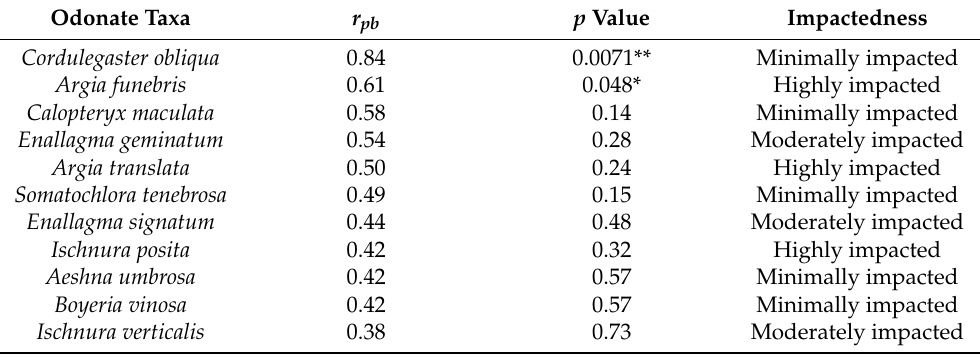
Table 6. Results from the Indicator Species Analysis for resident odonate taxa with multiple detections across sampling seasons. Point-biserial correlation coefficients are designated as ( r pb ) and p -values were calculated using 9999 permutations. Impactedness refers to the site class each odonate species is an indicator for. Significance codes: ‘***’ p <0.001; ‘**’ p <0.01; ‘*’ p <0.05; ‘ · ’ p <0.1. Odonate Taxa r